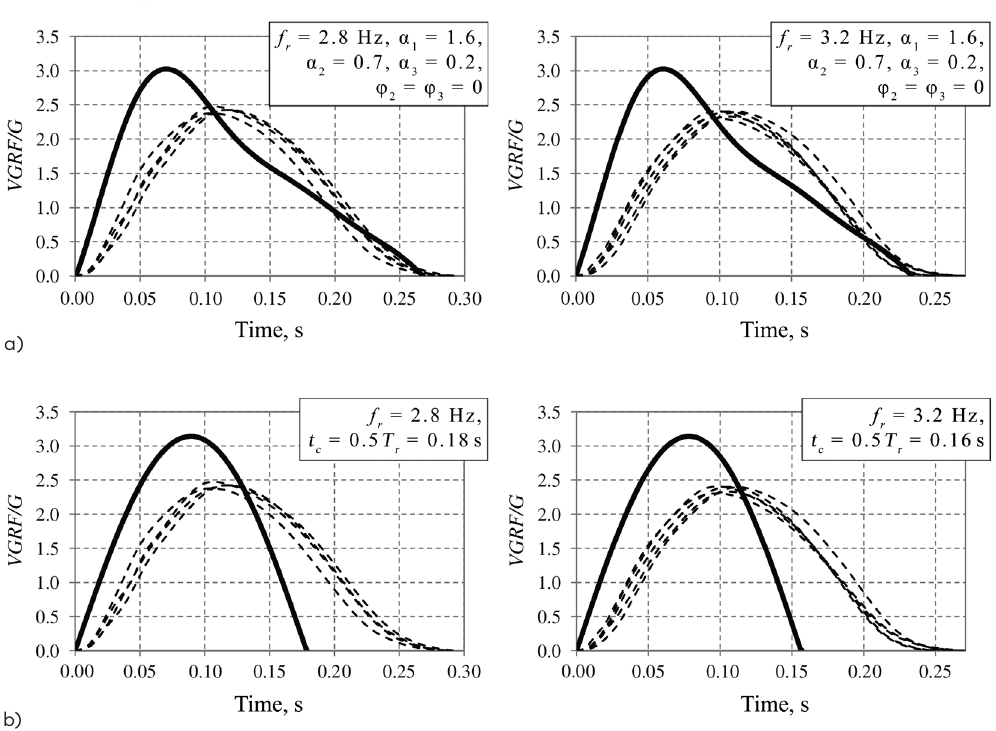
Figure 6. The normalised VGRF / G determined for f r = 2.8 Hz and f r = 3.2 Hz using: a) Eq. (1) for the input parameters by Bachmann et al. (1995), b) Eq. (2) for the input parameters by Occhiuzzi et al. (2008) (input parameters presented in the charts)